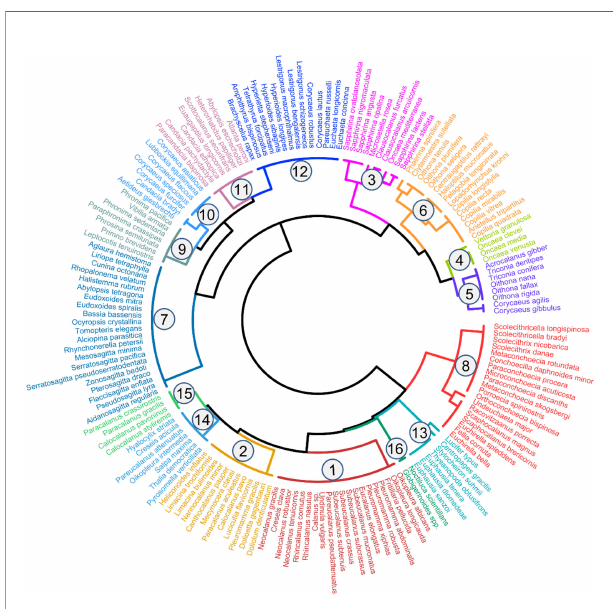
FIGURE 5 | Dendrogram of functional groups of zooplankton identi fi ed on the basis of functional traits (numbers represent each group).